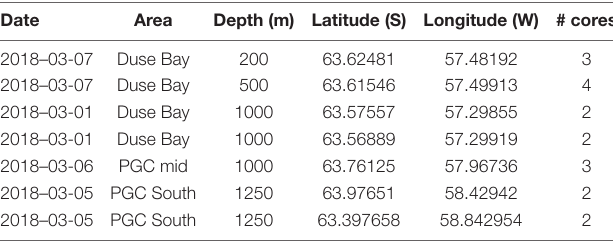
TABLE 1 | Overview of stations sampled during the RRS James Clark Ross cruise JR17003a (February–March 2018). Date